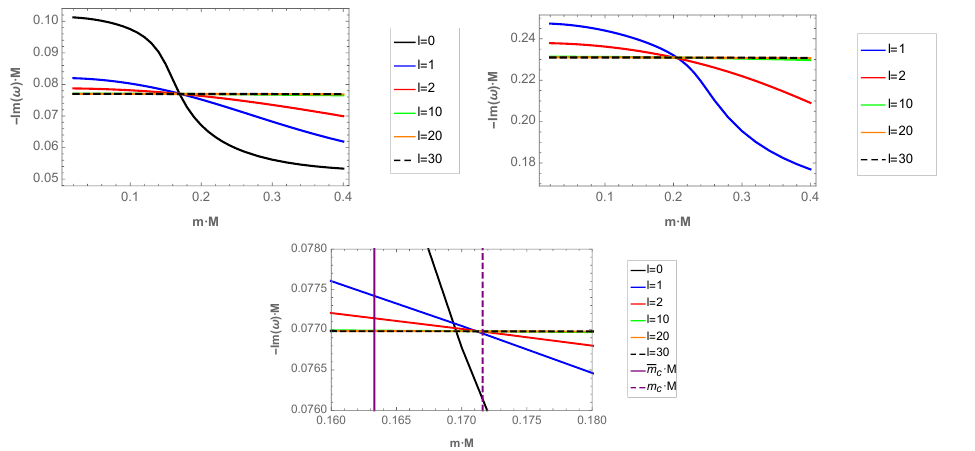
Figure 2 . Top panel for the behaviour of Im ( ! ) M of the photon sphere modes, top-left panel for the dominant mode n PS = 0, and right top-right panel for the (cid:12)rst overtone n PS = 1, as a function of mM for di(cid:11)erent values of the parameter ‘ = 0 ; 1 ; 2 ; 10 ; 20 ; 30 (top-left panel), and ‘ = 1 ; 2 ; 10 ; 20 ; 30 (cid:21) n PS (top-right panel), with M 2 (cid:3) = 0 : 04. Bottom panel corresponds to a zoom of the top-left panel, for the range 0 : 16 < mM < 0 : 18, (cid:22) m c M (cid:25) 0 : 1633, and m c M (cid:25) 0 : 1716 (WKB).